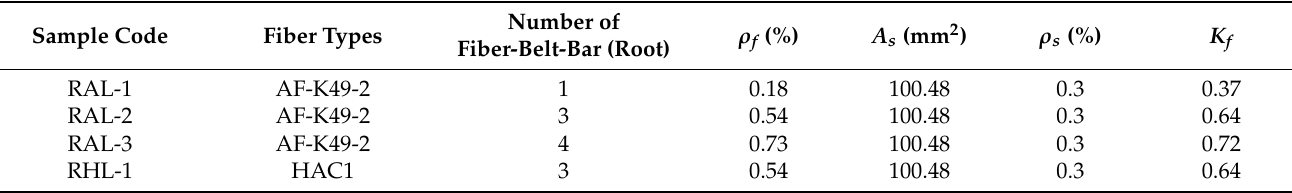
Table 2. Details of the beam specimen parameters.